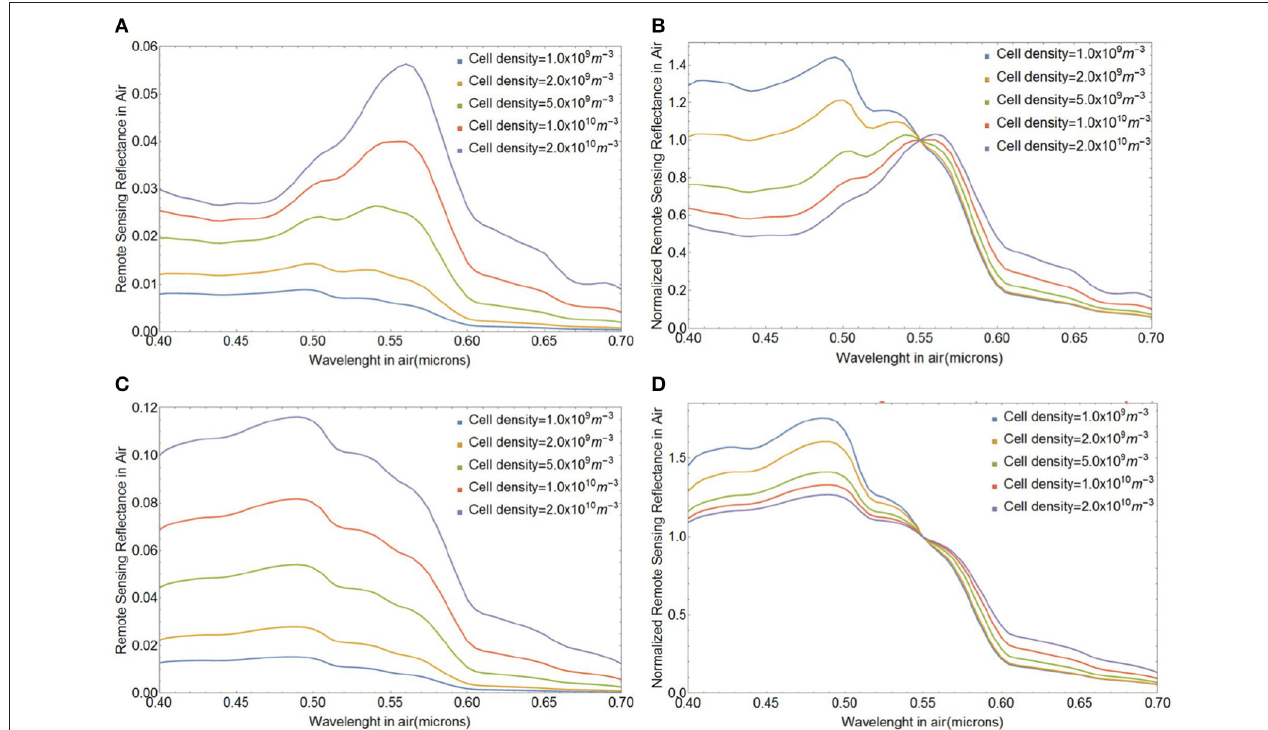
FIGURE 8 | Variability in the spectral remote sensing reflectance R rs ( λ ) (in sr − 1 ) during coccolith shedding by E. huxleyi in blooms with various initial coccolithophore concentrations and for a coccolith size distribution with a mean a 0 of 1.7 µ m and standard deviation of 0.15 µ m and coccospheres with four layers of liths. (A) Initial stage with all liths attached ( F nc 0), (C) final stage with all liths shed ( F nc 1) and no living cores remaining ( F sc 0). Spectra in (B,D) were normalized at a = = = wavelength of 0.55 µ m. Note that the lith concentration in panels (C,D) is simply 36 times the cell